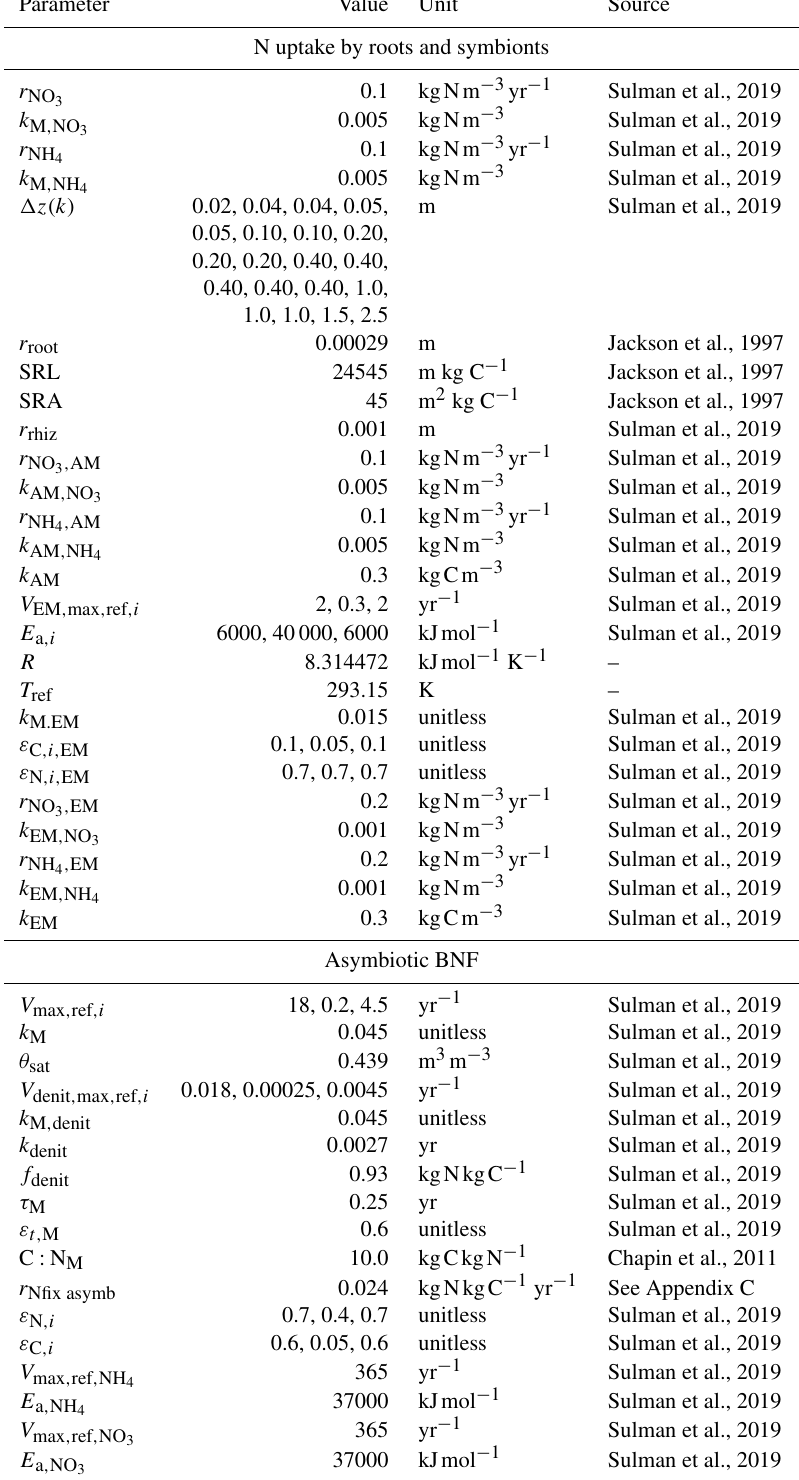
Table D2. General